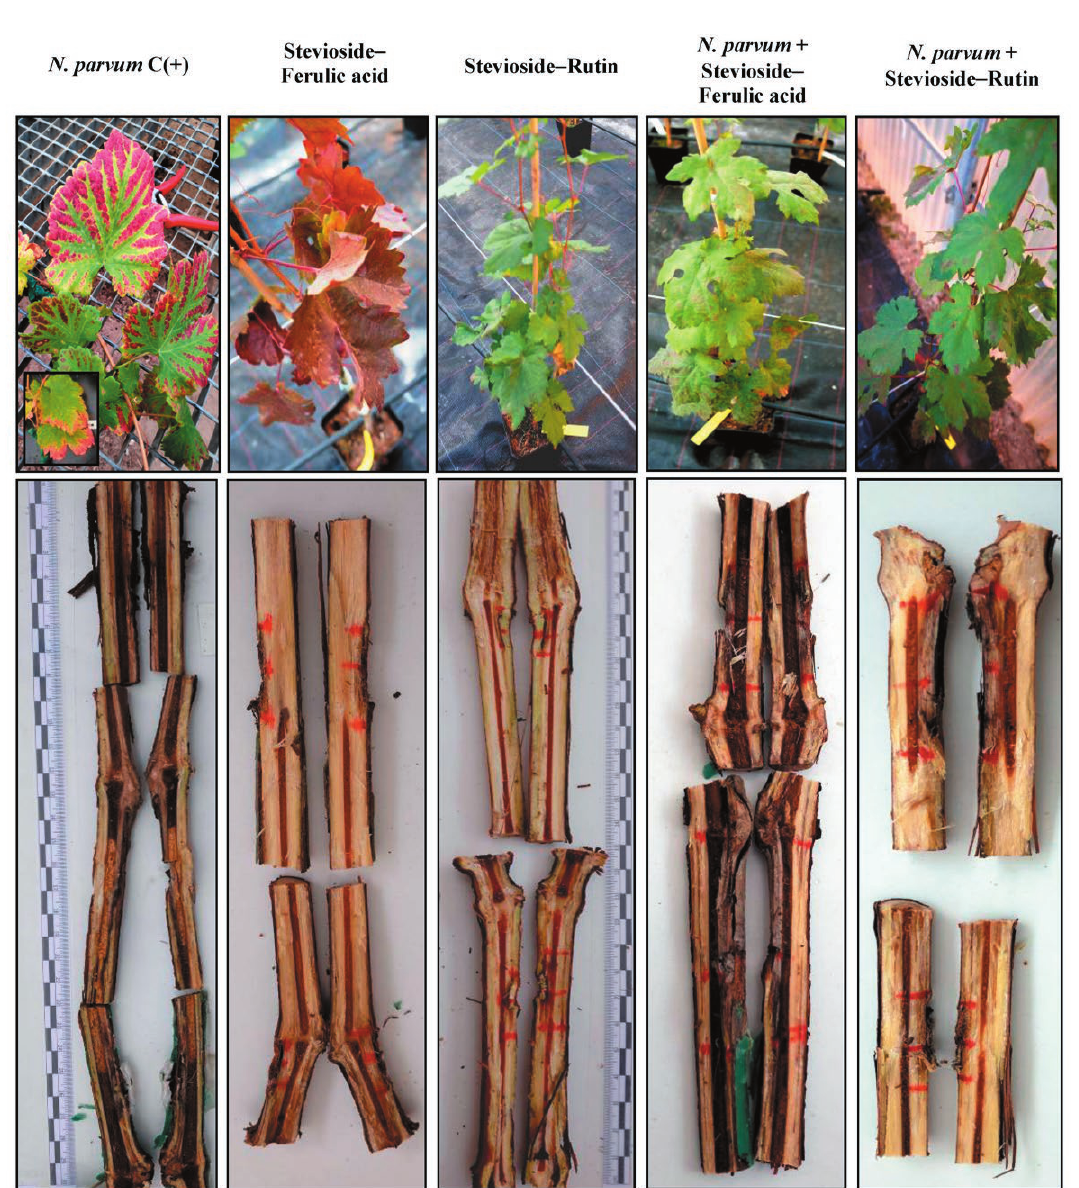
Figure 2. Foliar symptoms and vascular necroses observed in grapevine plants artificially inoculated with Neofusicoccum parvum and treat- ed with two conjugate complexes of natural products. Top row, left to right; general aspect of plants treated with N. parvum (positive con- trol), stevioside-ferulic acid, stevioside-rutin, N. parvum + stevioside-ferulic acid and N. parvum + stevioside-rutin. Bottom row; vascular lesions after sectioning the stems of the grapevine plants in the top